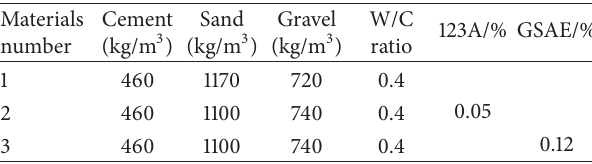
Table 3: Mix proportion of tested wet-mix shotcrete.